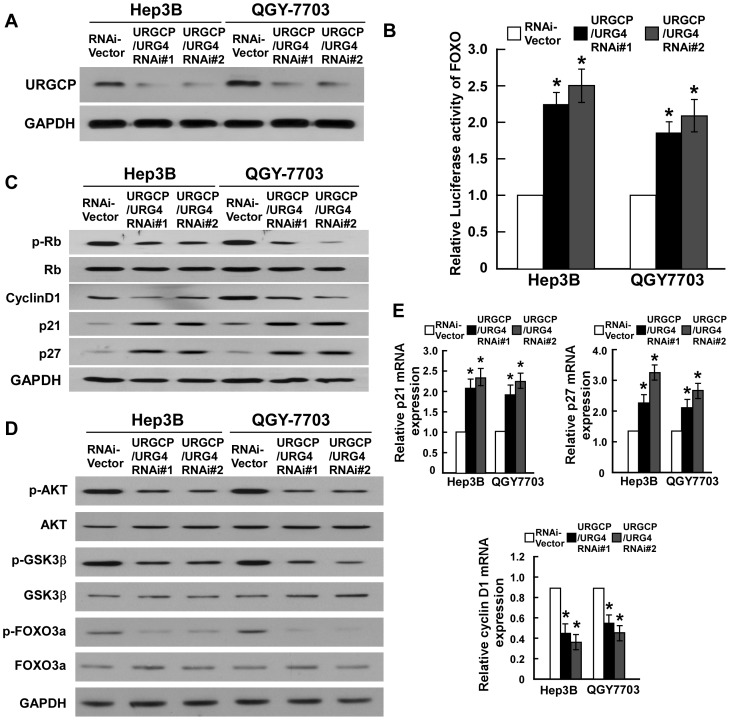
Downregulation of URGCP/URG4 enhances transcriptional activity of FOXO3a.Knockdown of URGCP/URG4 in two specific shRNA-transduced HCC cell lines (A). Relative FOXO3a reporter activity in cells transduced with vector, URGCP/URG4 shRNA#1 or URGCP/URG4 shRNA#2 (B). Western blotting analysis of phosphorylated Rb (p-Rb), total Rb, p21Cip1, p27Kip1 and cyclin D1 proteins in indicated HCC cells (C). Western blotting analysis of phosphorylated Akt (p-Akt), total Akt, phosphorylated GSK-3β (p-GSK-3β), total GSK-3β, phosphorylated FOXO3a (p-FOXO3a-Ser253) and total FOXO3a proteins in indicated HCC cells (D). Relative mRNA expressions of p21Cip1 (left panel), p27Kip1 (right panel) and cyclin D1 (lower panel) in indicated HCC cells were determined by real time RT-PCR (E). GAPDH was used as a loading control for all Western blots and mRNA expression levels were also normalized to GAPDH. Error bars represent SD from three independent experiments. *P<0.05.